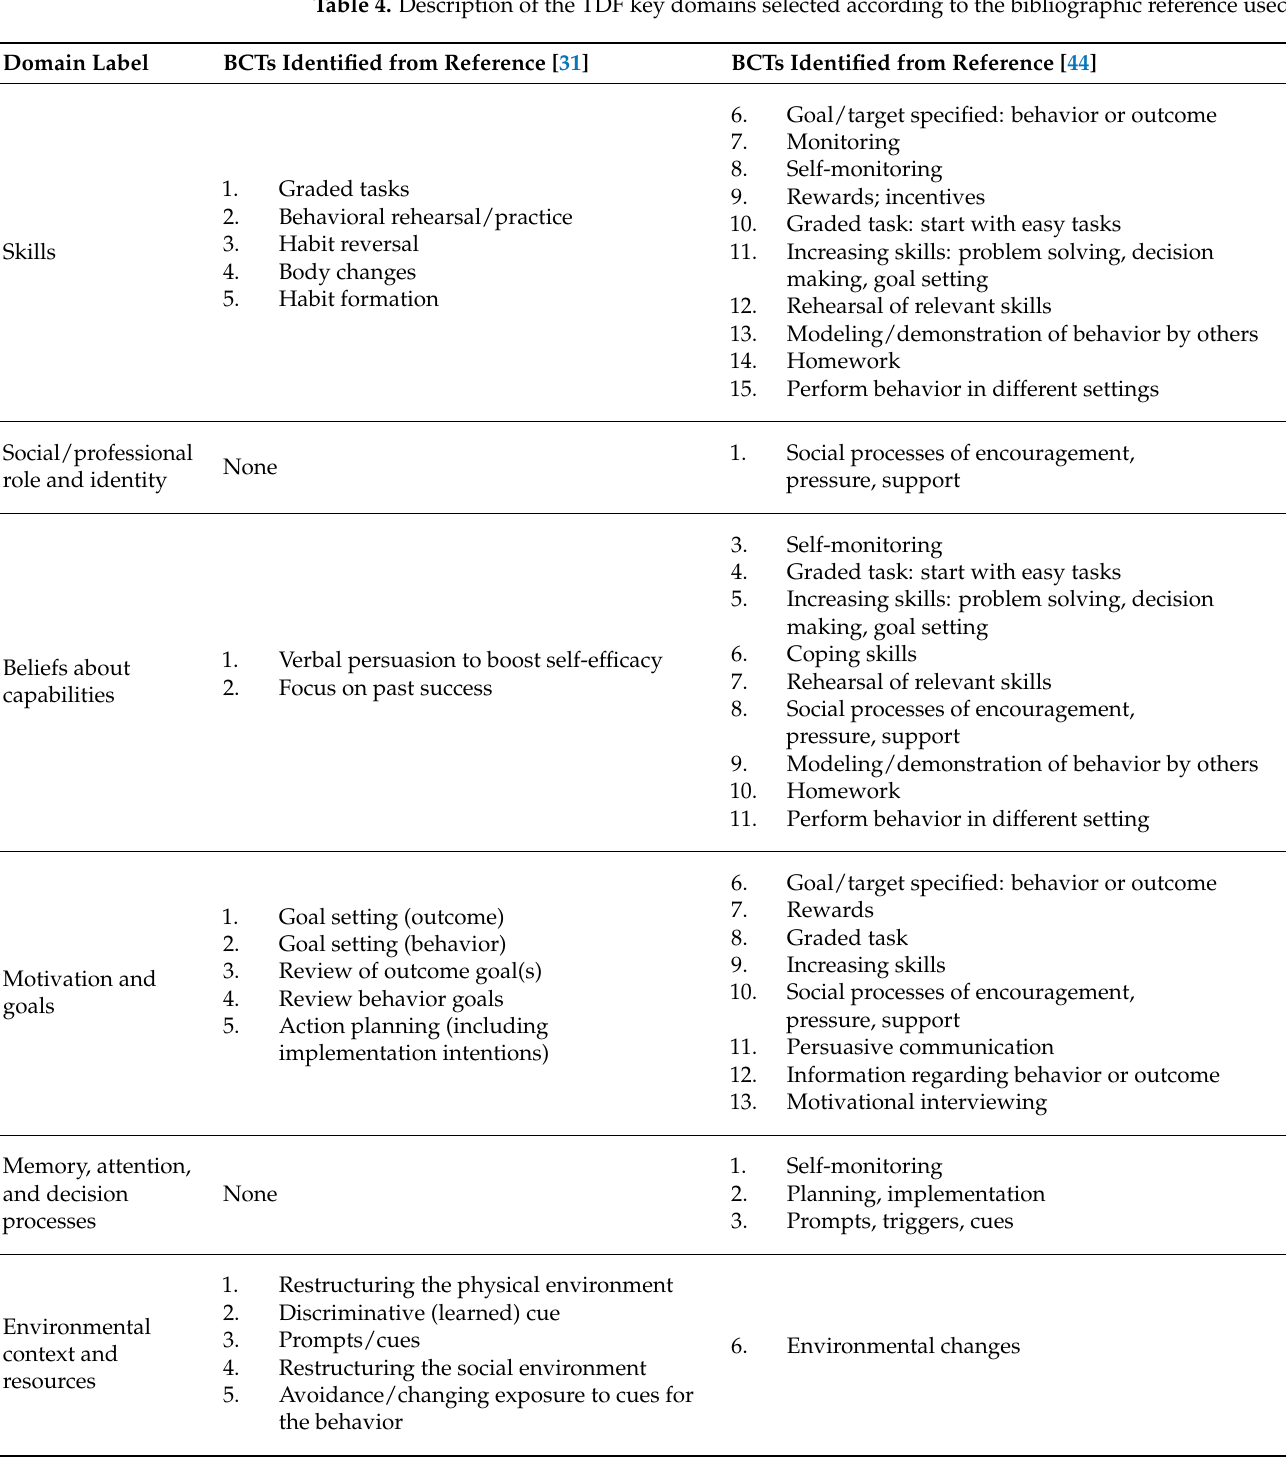
Table 4. Description of the TDF key domains selected according to the bibliographic reference